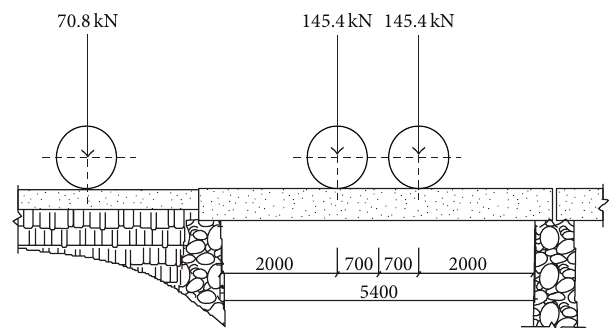
Figure 8: Loading trucks along the bridge’s lengthways direction.